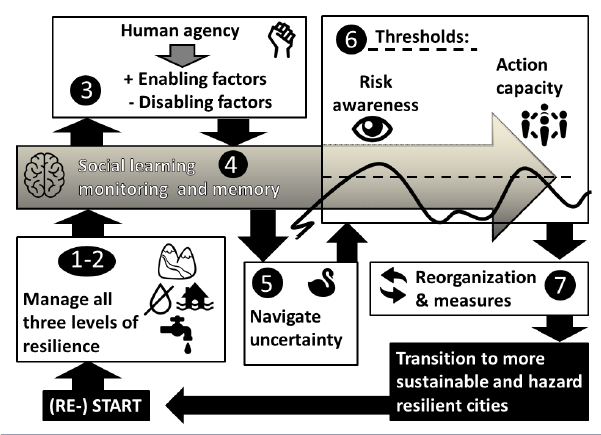
Fig. 3 . A conceptual model for the process of transition into a more sustainable and hazard-resilient state of urban